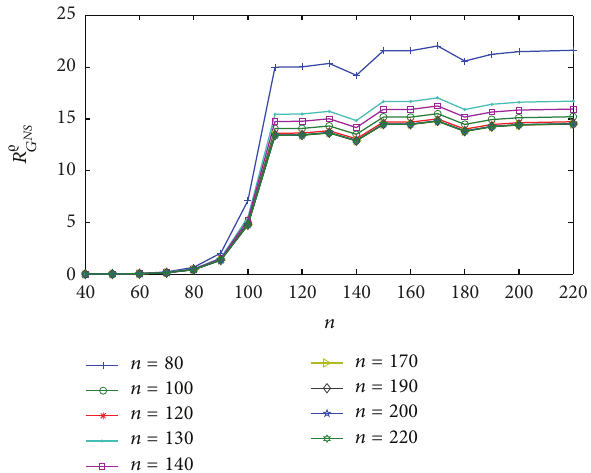
Figure 11: R 󰜚 when 󰜚 = 5 by fixing 𝑛 for ℎ −1 = 32 for different 𝑛 𝐺 𝑁𝑆 values of ℎ −1 = 64